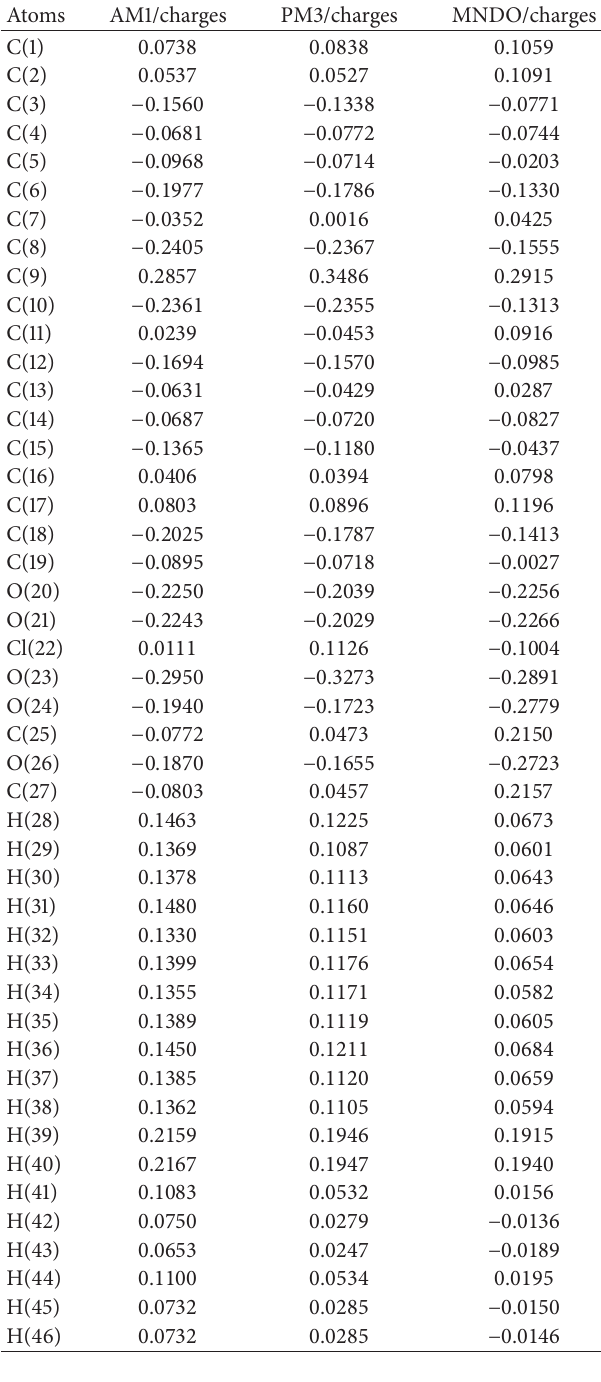
Table 1: Mulliken charges for 5-chlorocurcumin using AM1, PM3, and MNDO methods.